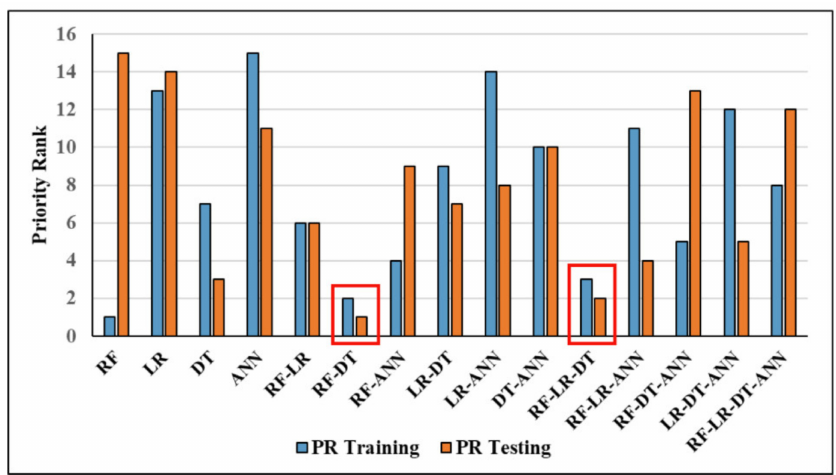
Figure 10. Prioritization results of all models using compound factor (CF) analysis used in the training and testing